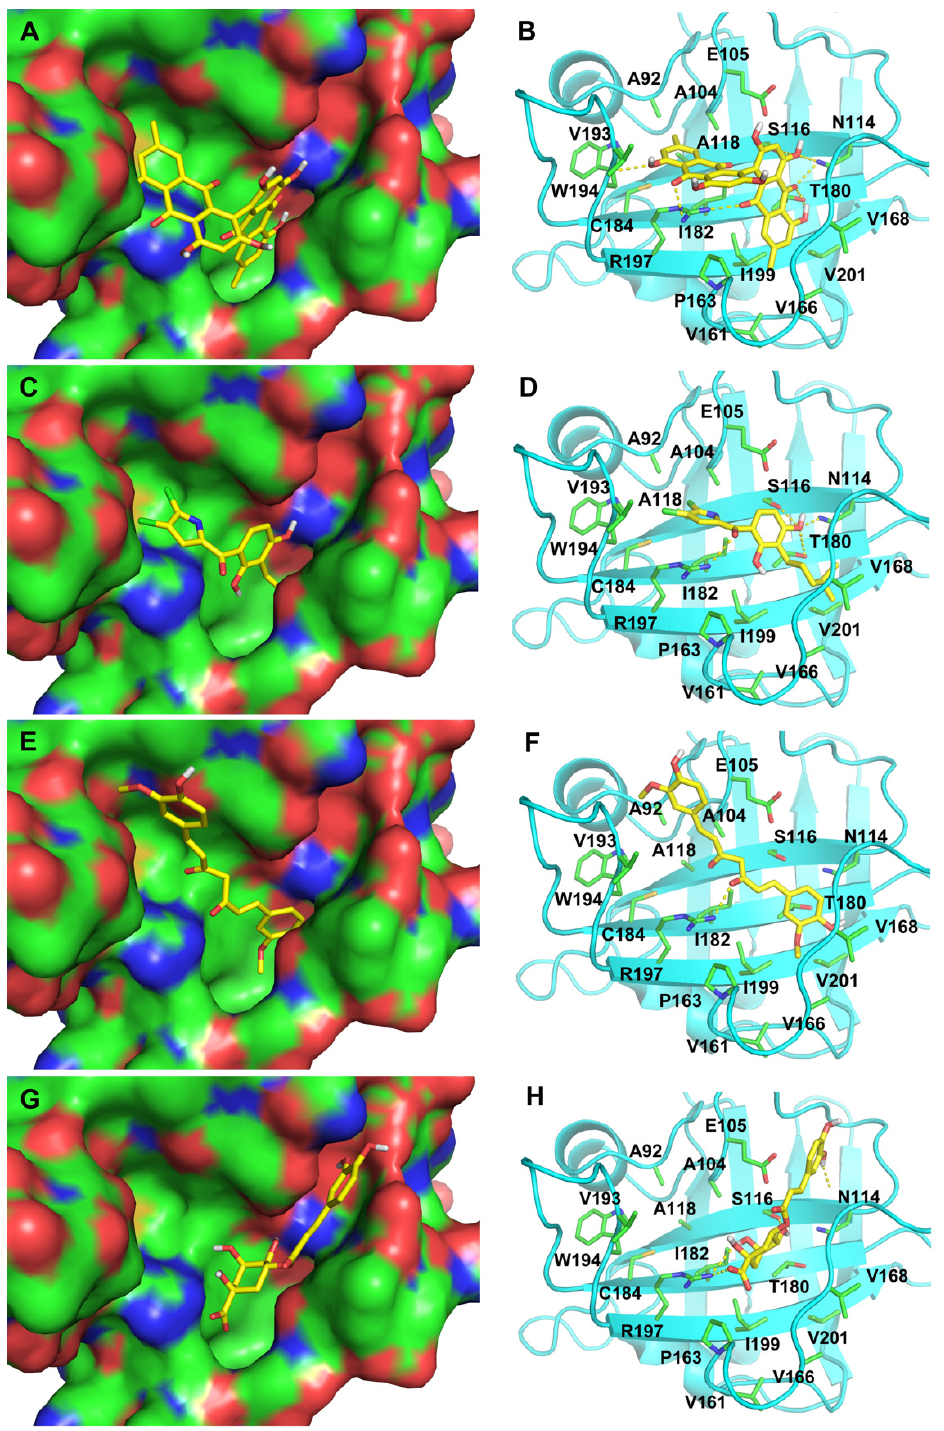
Figure 3. Docking poses of four compounds, namely ( A , B ), N1287, ( C , D ) N2576, ( E , F ), curcumin, and ( G , H ) chlorogenic acid. The compounds are shown as stick. The ligand binding site in the SrtA apo structure (PDB ID: 1T2P) is shown as surface in the panels on the left side ( A , C , E , G ), and as cartoon in the panels on the right side ( B , D , F , H ) with the sidechains of the binding residues highlighted as stick. These figures are generated by PyMOL